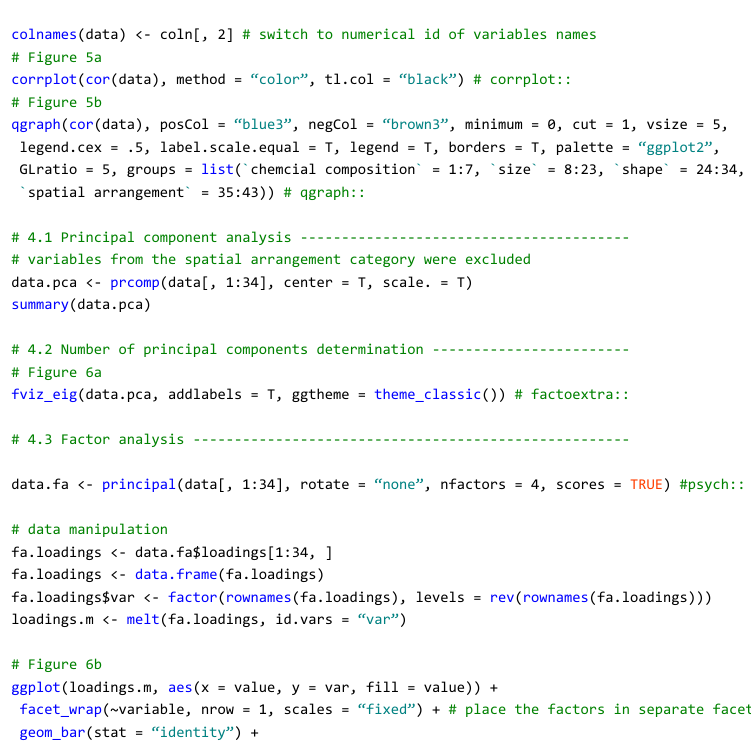
# Figure 6b ggplot(loadings.m, aes(x = value, y = var, fill = value)) + facet_wrap(~variable, nrow = 1, scales = “fixed”) + # place the factors in separate facets geom_bar(stat = “identity”)